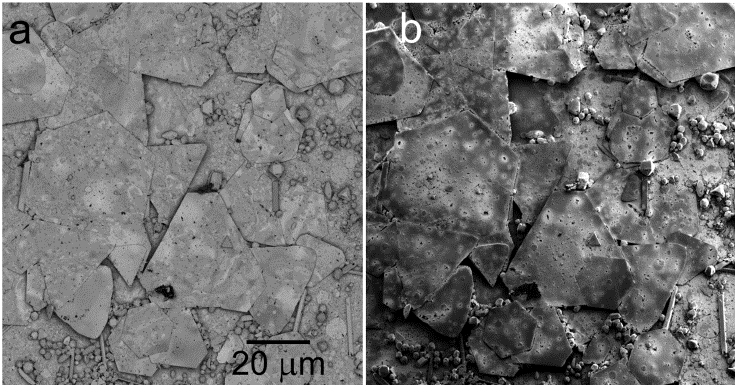
Figure 3. Microcrystalline Au deposited on glass. ( a ) Standard BSE imaging at 6 keV; ( b ) Sample in 1 kV/mm, landing energy of electrons 5